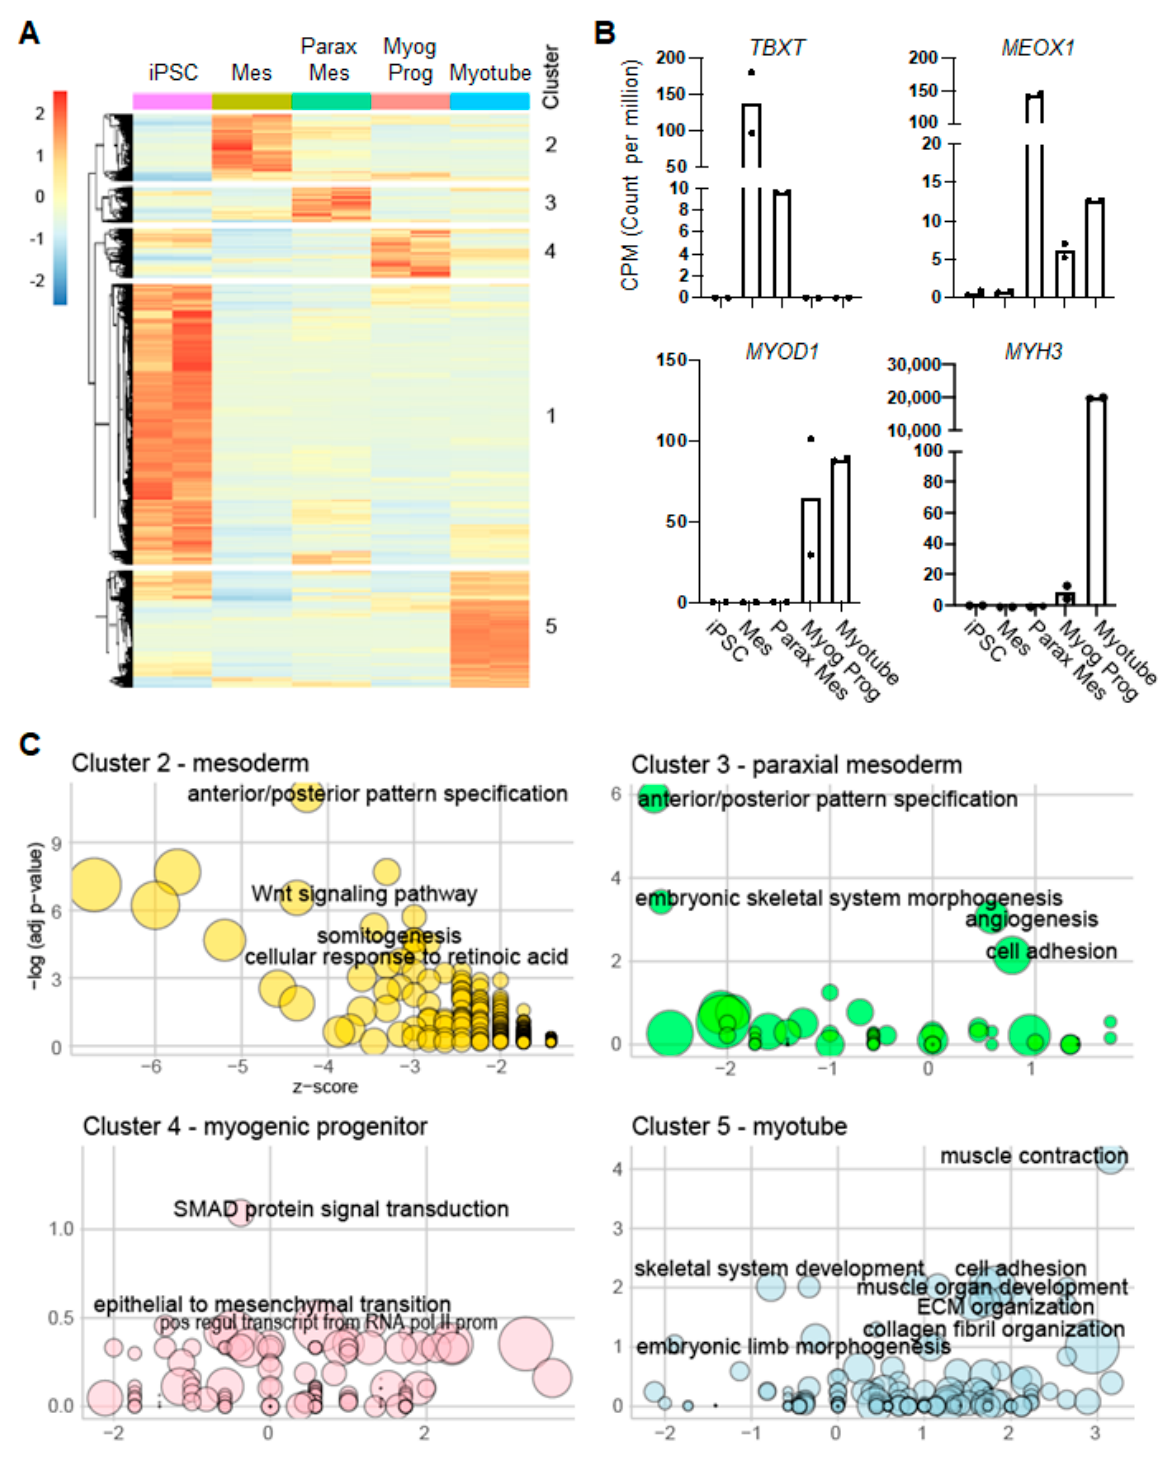
Figure 2. Transcriptional characterization of differentiating NHP iPAX7 iPS cells: ( A ) Heatmap representing unsupervised clustering of differentially expressed transcripts identified during the skeletal myogenic specification of NHP iPAX7 iPS cell lines. Clusters are enumerated from 1 to 5. Pluripotent stem cells: iPSC; uncommitted mesoderm: Mes; paraxial mesoderm: Parax Mes; myogenic progenitors: Myog Prog; myotubes: Myotube; ( B ) expression of selected genes charac- terizing the clusters identified in panel ( A ). Dots represent replicates; ( C ) functional classification based on gene ontology (GO) analysis using DAVID. Genes from clusters 2 to 5 were analyzed